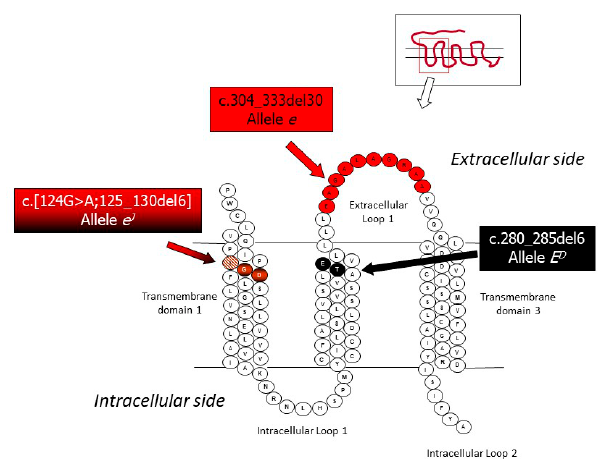
Figure 1. A detail of the 2D structure of the rabbit MC1R protein with indicated the amino acids that are eliminated by the three in-frame deletions that cause the E D (and/or E S ; see the text), e J , and e alleles at the Extension locus (modified from [42]).